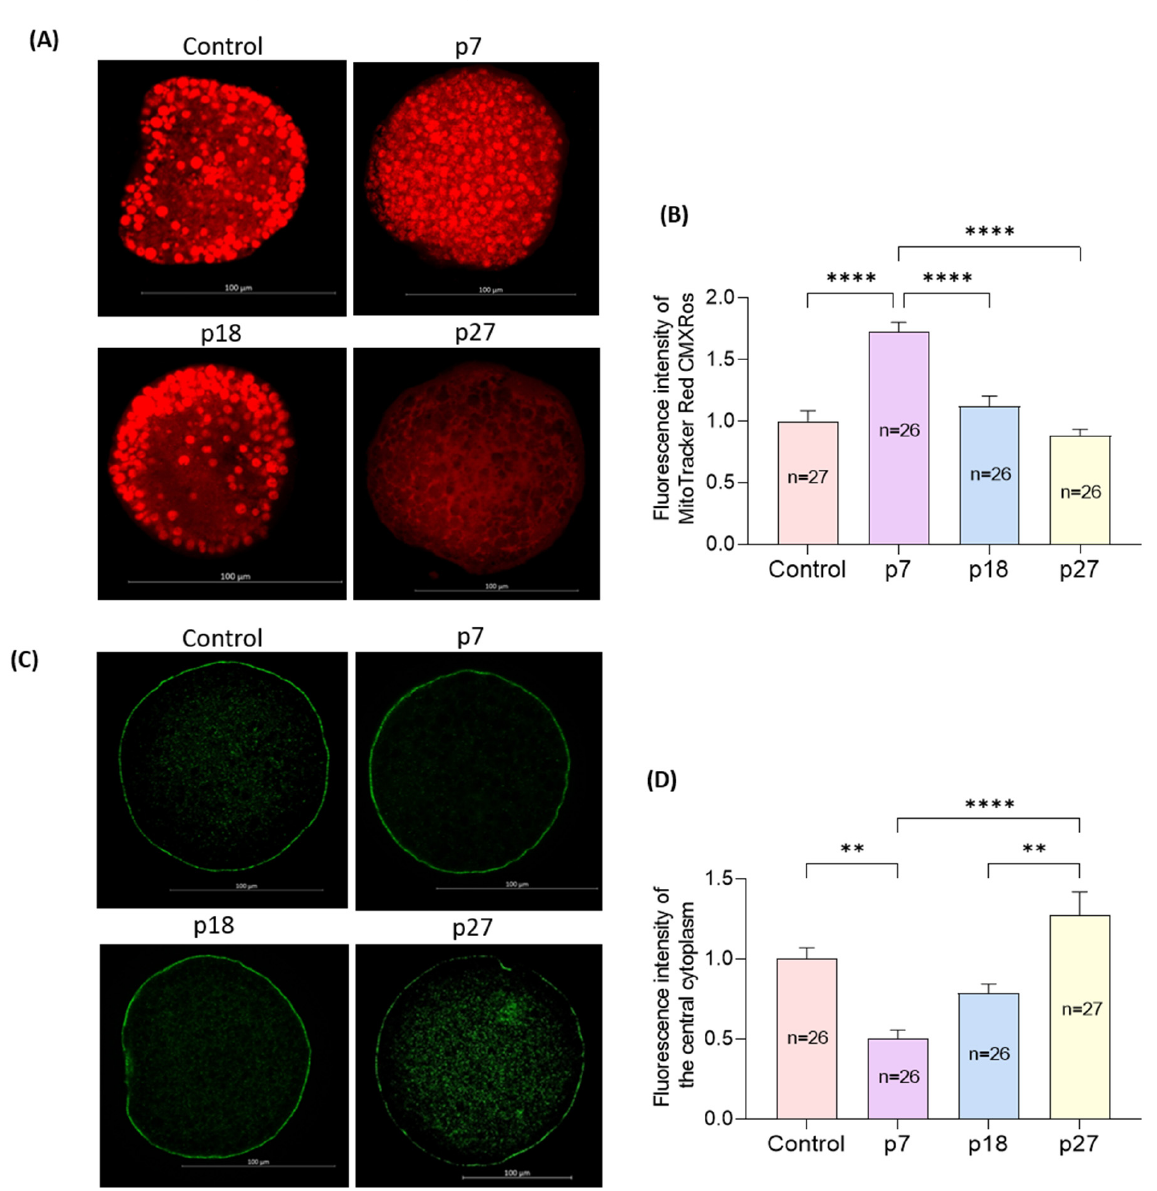
Figure 4. Effects of different passages of eAFMSC-CM on oocyte cytoplasmic maturation. ( A ) Representative images of mitochondrial distribution patterns in porcine oocytes. Control, p18: Heterogeneous, non-aggregated mitochondrial distribution. p7: Homogeneous, non-aggregated mitochondrial distribution. p27: Aggregated mitochondrial distribution. ( B ) Fluorescence intensity of MitoTracker Red CMXRos in MII porcine oocytes. ( C ) Representative images of CGs distribution in porcine oocytes. The CGs of p7 have migrated into the cortical area, and other groups still remained in the central cytoplasm. ( D ) Fluorescence intensity of the central cytoplasm in MII porcine oocytes. The asterisks represent significantly different when compared to the control (**: p < 0.01, ****: p < 0.0001). Scale bar = 100 μ m.